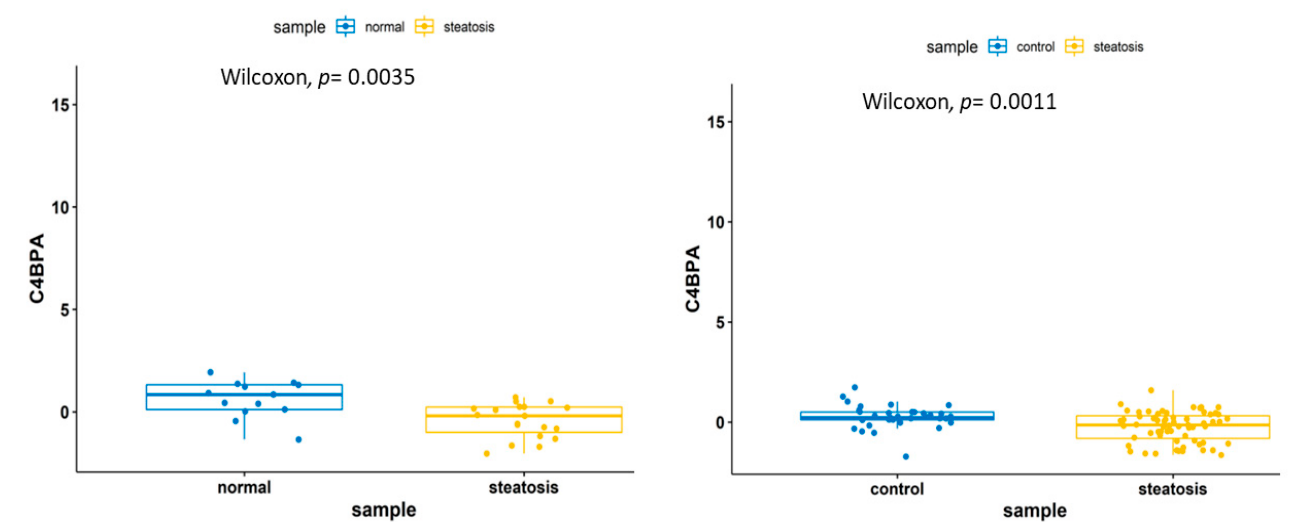
Figure 7. A boxplot showing the downregulation of the C4BPA gene in the steatosis samples.